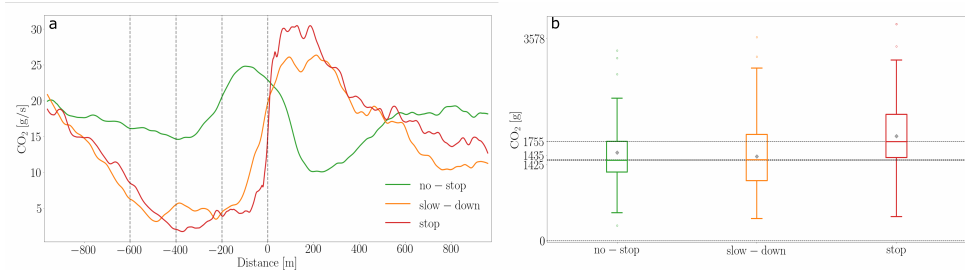
Figure 5. ( a ) Median instantaneous CO 2 flow for the three groups. Green, amber, and red represent the no-stop, slow-down, and stop groups, respectively. Position is relative to the location of the intersection as described on OSM. Vertical dashed lines denote the different regions used to group the speed profiles (see Section 2). ( b ) Results for the CO 2 flow for the three groups. Green, amber, and red represent the no-stop, slow-down, and stop groups, respectively. Differences between all groups are significant.